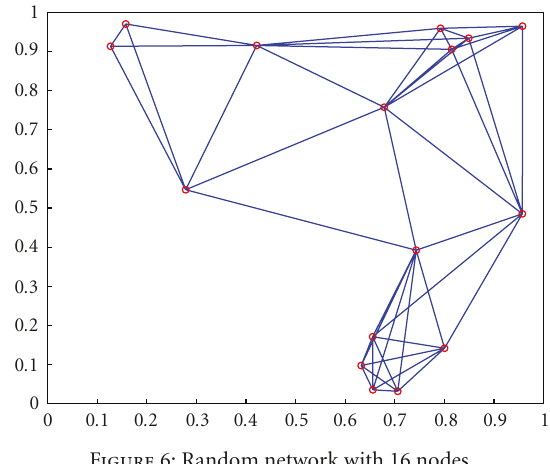
Figure 6: Random network with 16